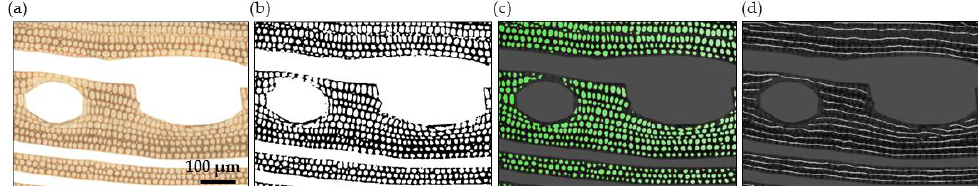
Figure 3. Flowchart of the preparation of a segment of a sanded surface on Pycnanthus angolensis for measurement of fibre wall thickness and lumina diameter. ( a ) Original sanded and scanned image, where parenchyma and vessel lumina were masked (obtained with Weka segmentation plugin in imageJ). ( b ) Binarization of the image in order to separate fibre lumina and walls. ( c ) Recognition and labelling of individual cells and ( d ) tracking and linking of individual cells. Pixel intensity is then analysed along the numerous created paths and the widths of lumina and fibre walls extracted. Scale 100 µm.